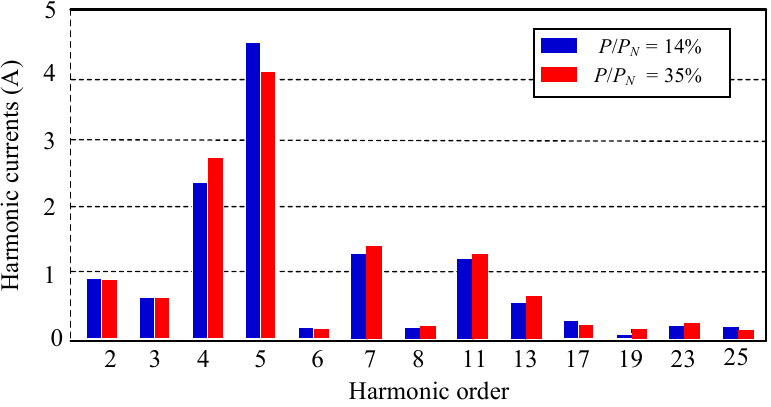
Figure 5. Fast Fourier transformation results on the output currents of wind farm operating with different wind power ratios.